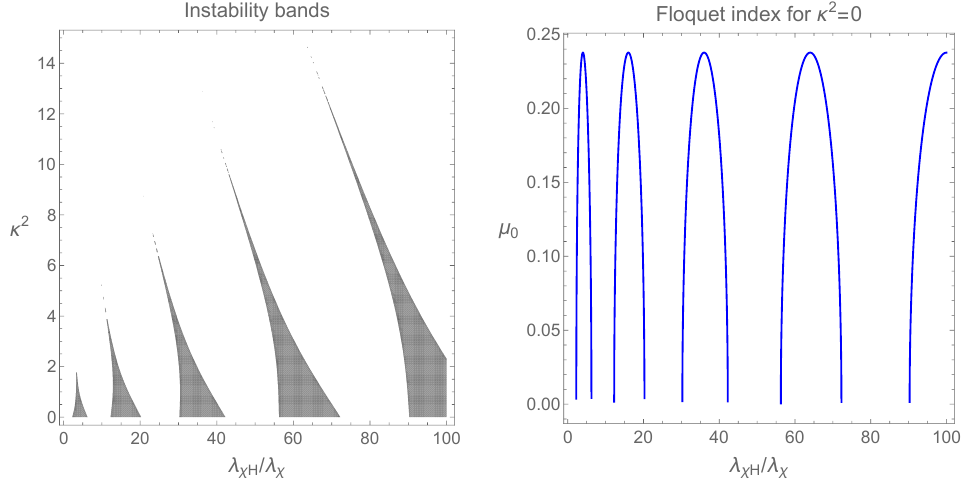
Figure 3 . (Left) Instability bands for preheating in the parameter space, (cid:21) (cid:31)H =(cid:21) (cid:31) vs (cid:20) 2 (cid:17) k 2 = ( (cid:21) (cid:31) (cid:31) 2 ( t ) a ( t ) 2 ). (Right) Floquet index (cid:22) 0 for zero momentum as a function of (cid:21) (cid:31)H =(cid:21) (cid:31) . 0 On the left in (cid:12)gure 3, we show the instability bands for preheating in the parameter space for (cid:21) =(cid:21) and the comoving momentum (cid:20) 2 (cid:17) k 2 = ( (cid:21) (cid:31) (cid:31)H